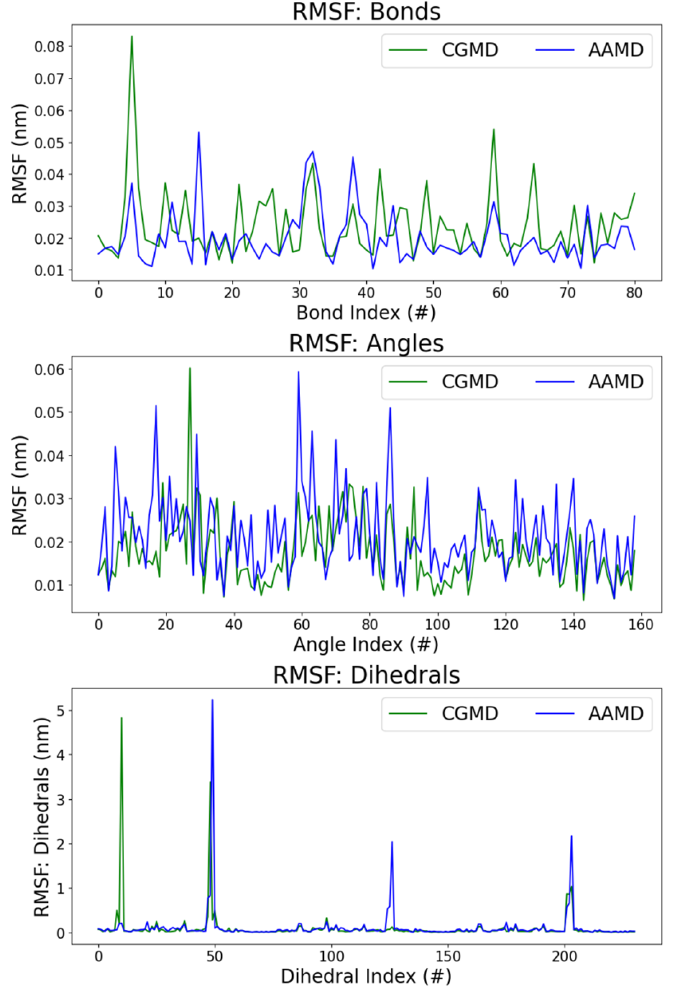
Figure A6. RMSF comparison between the proposed CGMD simulation and the AAMD validation simulations.